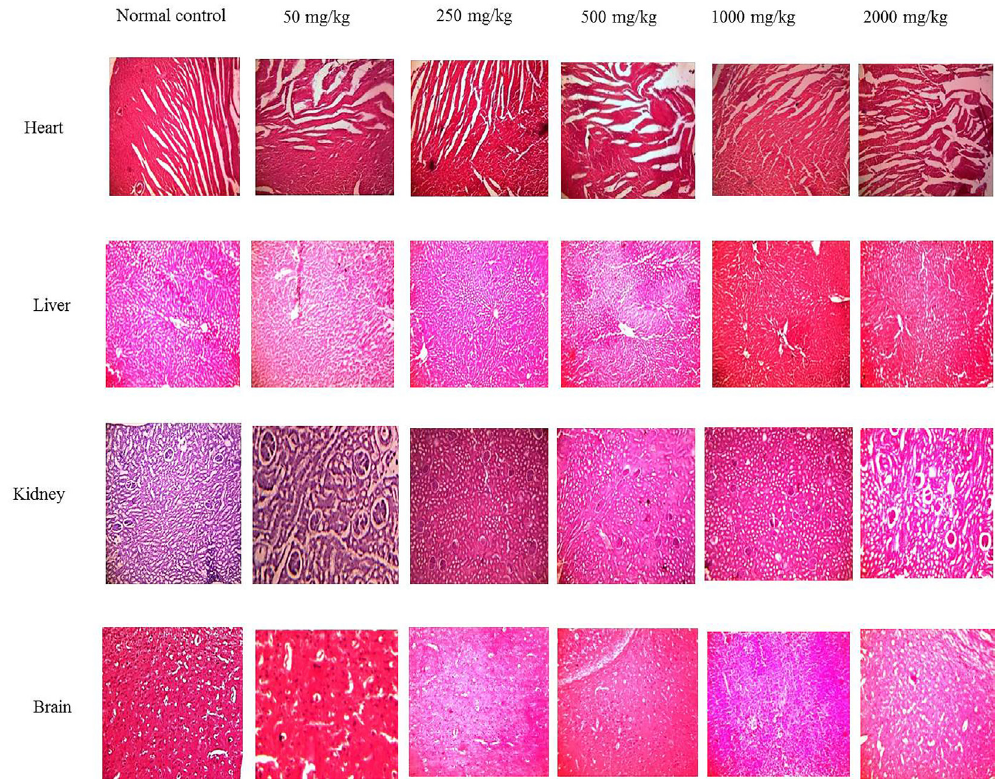
FIGURE 2 - Histopathology (H&E stain10x) of rat tissues of treated groups rats after 14th